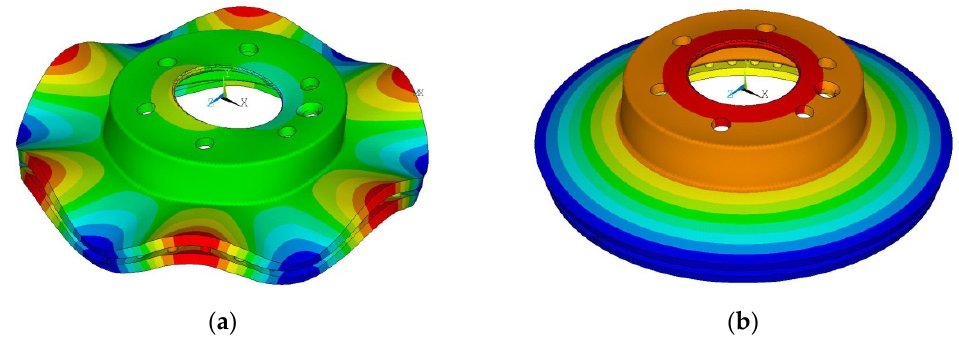
Figure 3. Out-of-plane modes: ( a ) diametrical bending; ( b ) circumferential bending.